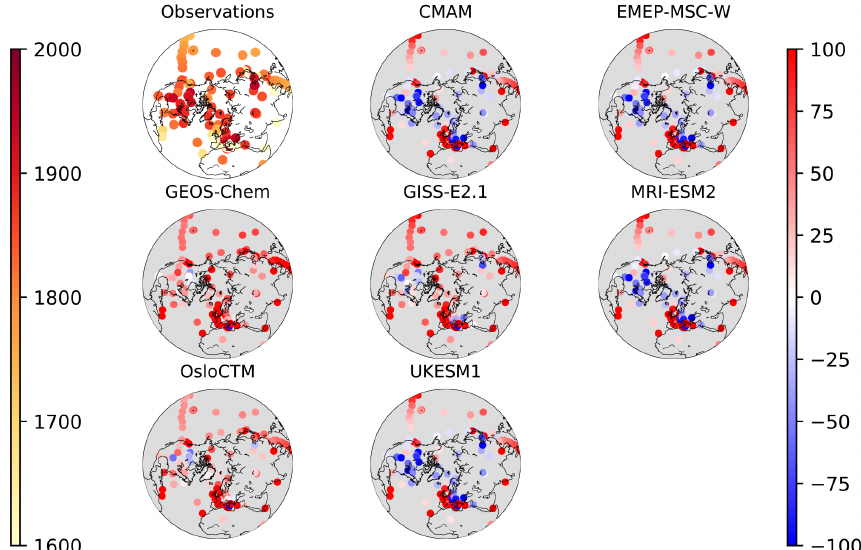
Figure 5. Measured surface-level methane (top left) (ppbv, left color bar) and (remaining panels) model biases (model minus measurement, also ppbv, right color bar) for 2014–2015.